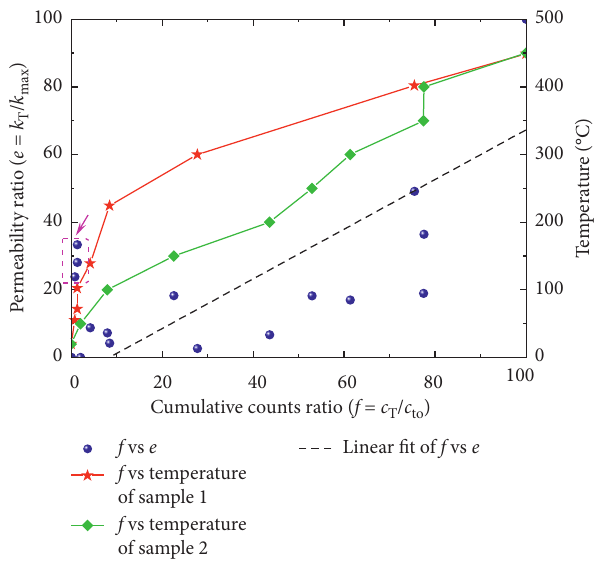
Figure 6: Relationship between cumulative counts and perme- ability of samples.